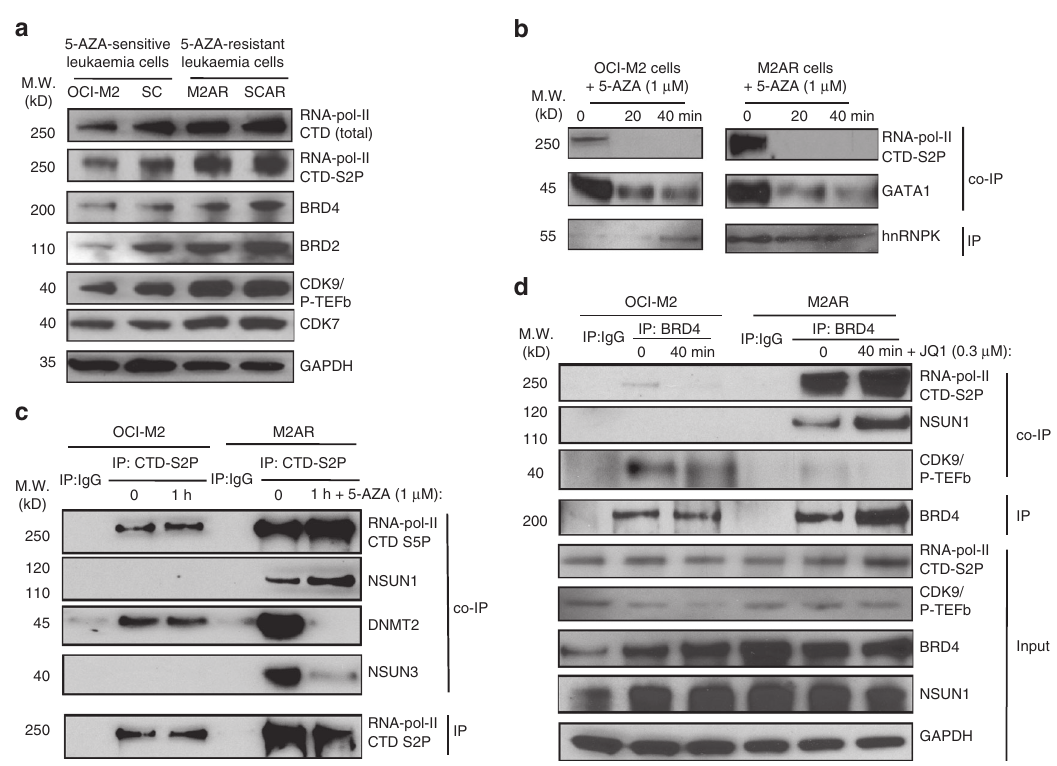
Fig. 6 Identi fi cation of unique interactions between RNA-pol-II CTD-S2P and NSUN1 as well as BRD4 in 5-AZA-resistant leukaemia cells. a Examination of the protein expression of the components of active RNA-pol-II complex, BRD4 and BRD2 in the 5-AZA-sensitive OCI-M2 and SC cells and the 5-AZA- resistant M2AR and SCAR cells by western blotting. b Examination of the effects of 5-AZA on the interactions between hnRNPK and RNA-pol-II CTDS2P as well as GATA1 in OCI-M2 and M2AR cells by IP and co-IP. c Elucidation of a unique 5-AZA-resistant interaction between RNA-pol-II CTD-S2P and NSUN1 in the 5-AZA-resistant M2AR cells by IP and co-IP. d Elucidation of unique interactions between BRD4 and RNA-pol-II CTD-S2P as well as NSUN1 in the 5-AZA-resistant M2AR cells by IP and co-IP and the effects of JQ1 on these interactions